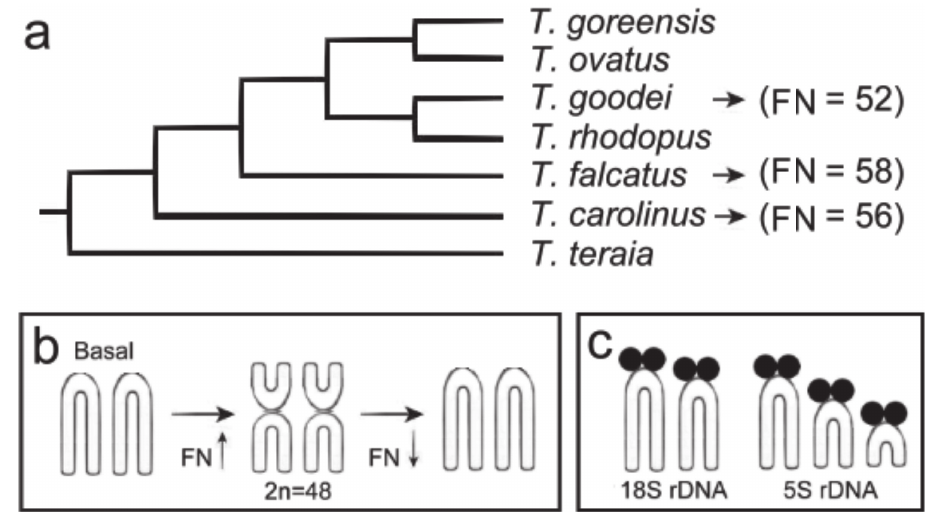
Figure 2. Phylogenetic tree from molecular data of some species of Trachinotini tribe ( a ), adapted from Reed et al. (2002). The molecular relationship is confronted with the chromosomal formula of the Trachinotus species analyzed. Schematic illustration shows the role of additional pericentric inversions leading to new acrocentric chromosomes and modification of the FN value ( b ), and the derived condition of multiple sites of 18S and 5S rDNAs in T. goodei ( c